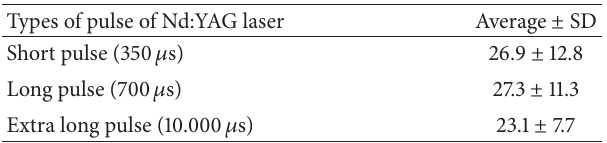
Table 1: Temperature changes ( ∘ C) in specimens of primary enamel, during Nd:YAG laser